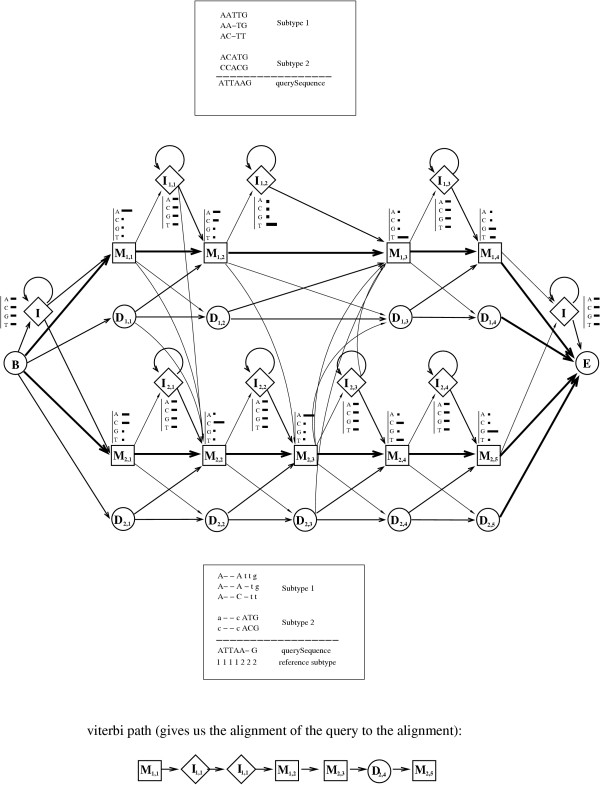
A toy example of a jumping profile Hidden Markov Model. This is build from a multiple sequence alignment of nucleotides with two subtypes. The first subtype consists of three sequences with four consensus columns, the second subtype consists of two sequences with five consensus columns. With each match and insert state a vector is associated for the emission probability values corresponding to the nucleotides A, C, G and T. For clarity, some transitions are omitted. Also, the figure does not show the delete states immediately after B from which each match state can be reached nor the delete state immediately before E that can be reached from each match state. Fat lines indicate high transition probabilities, thin lines correspond to low probabilities.